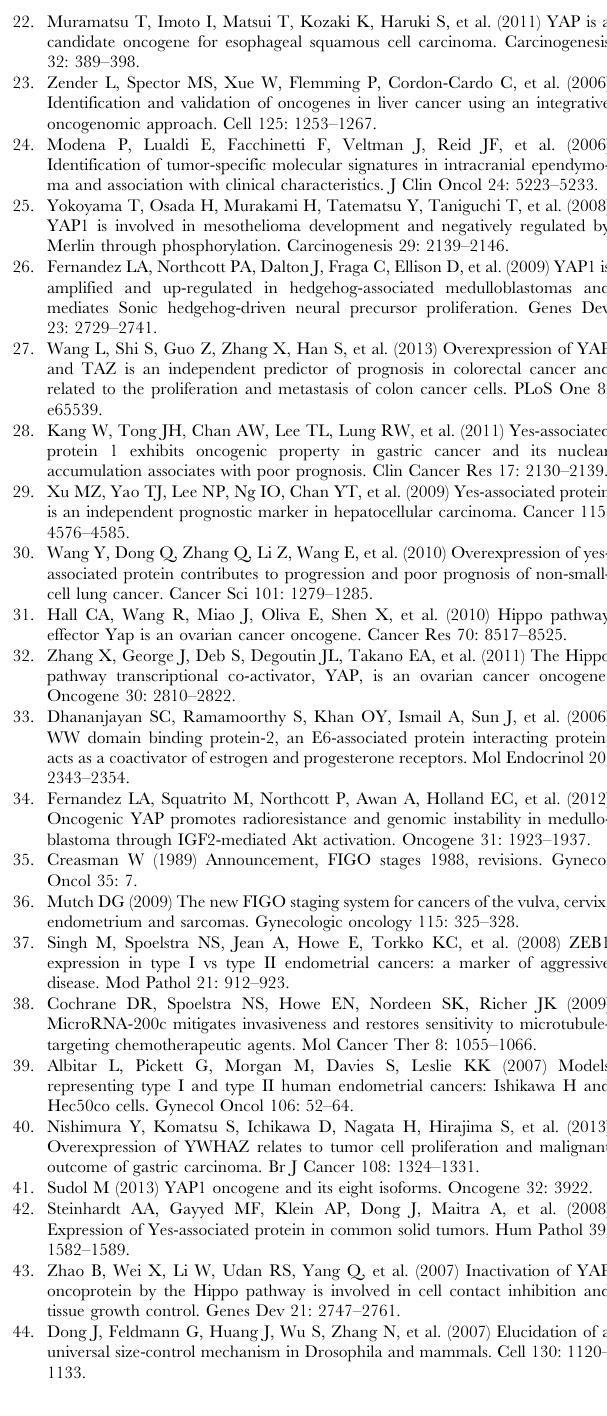
Table S1 Association of YAP expression in nucleus with clinicopathological factors in type2 endometrial can- cers.